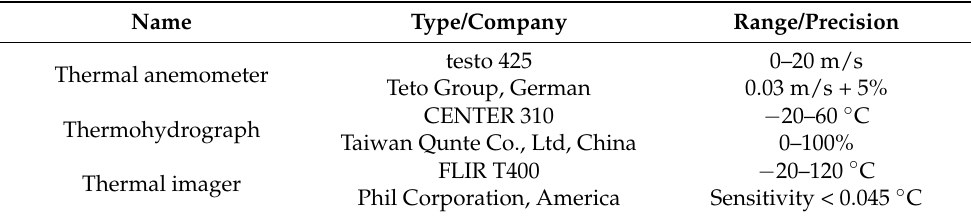
Table 1. Technical parameters of the sensors.